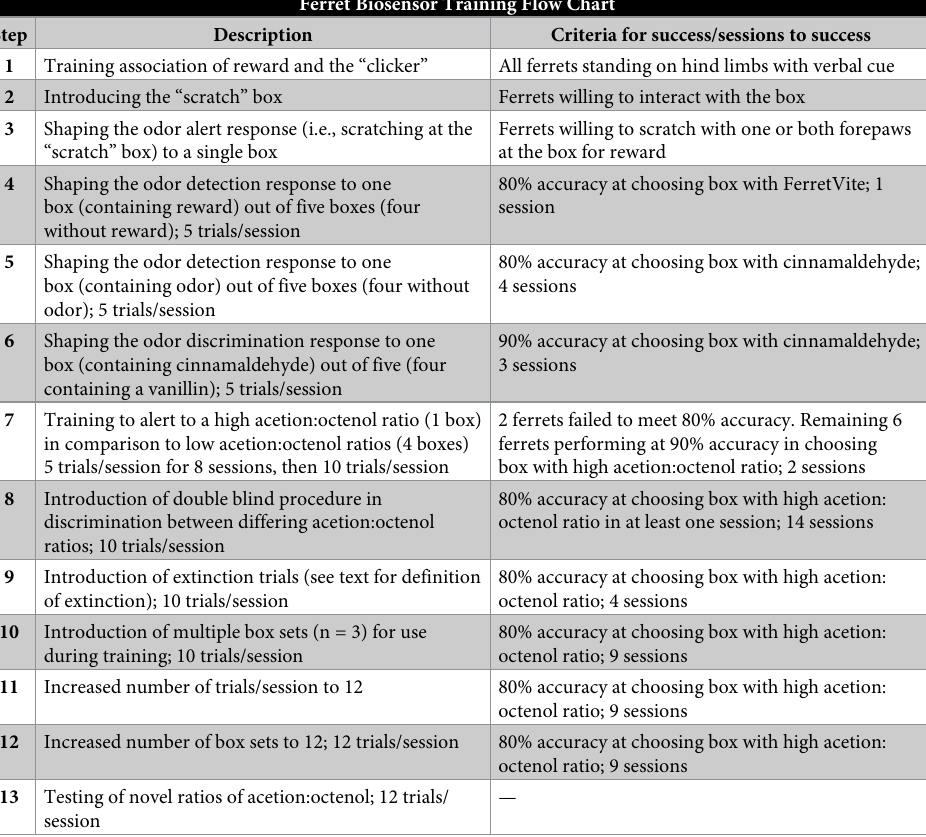
Table 1. Overall view of training the ferrets from introducing clicker training to testing in-between ratios of acet- oin: Octenol. Ferret Biosensor Training Flow